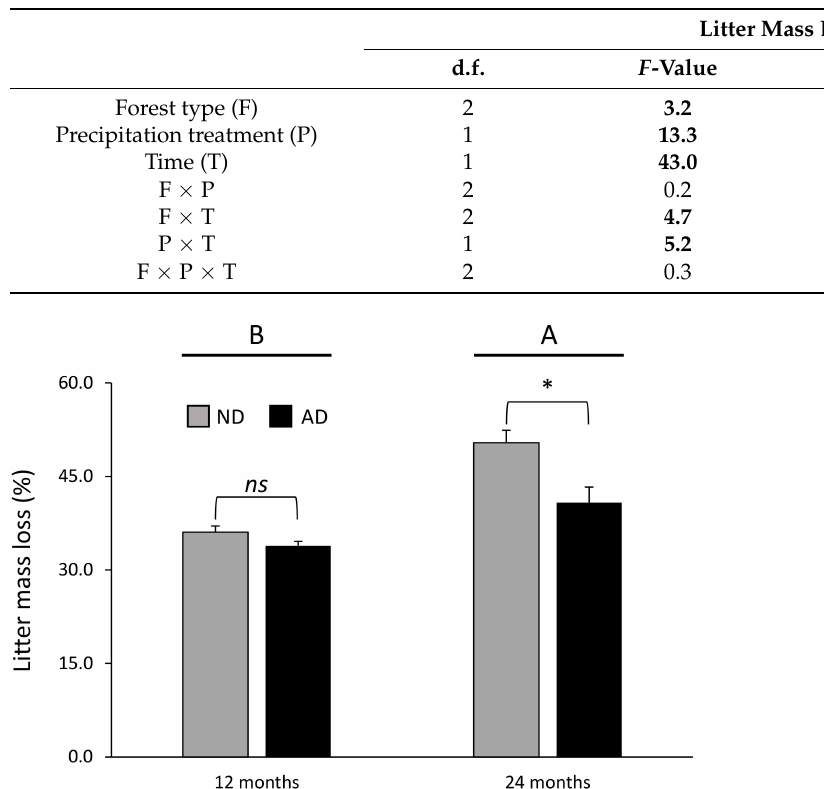
Figure 1. Litter mass loss according to the significant precipitation treatment × time of decomposition interaction (Table 2). Data are mean values ± SE and expressed as % of mass loss; n = 21. Different capital letters denote significant differences between time of decomposition with A > B (post hoc Tukey tests results). Stars indicate significant differences between precipitation treatments (* for P < 0.05). ND—natural drought, AD—amplified drought, ns —non